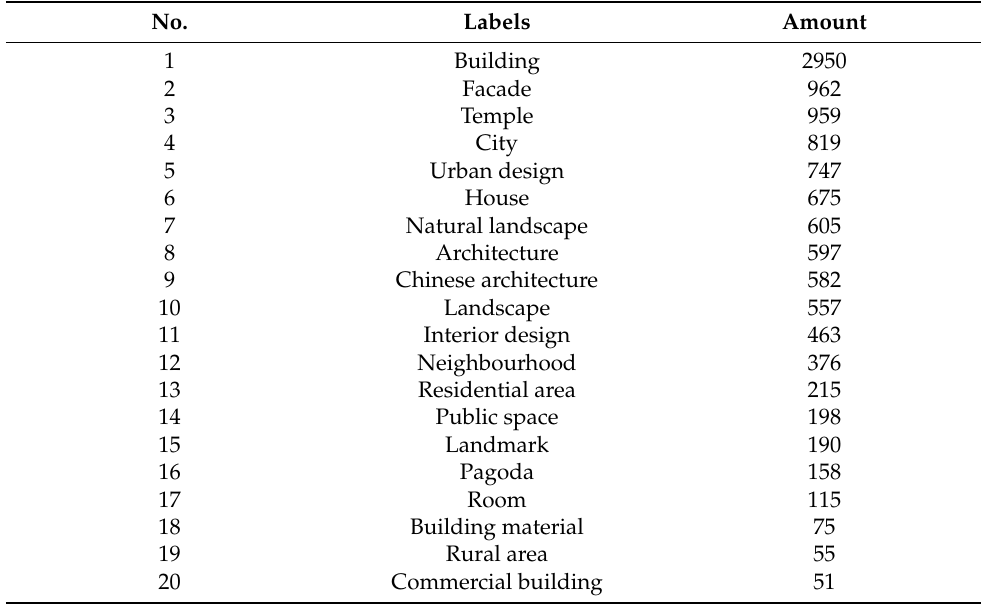
Table 6. Top 20 labels related to the morphological